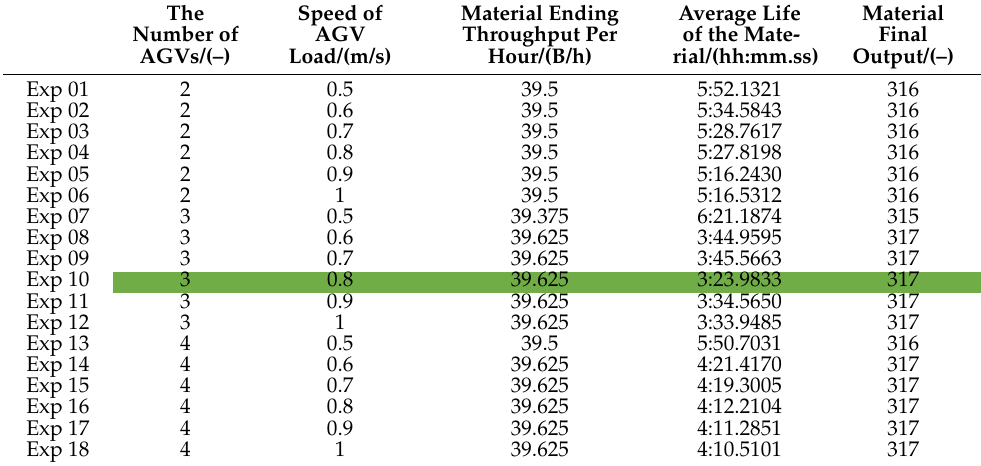
Table 10. Multi-level experiments for AGV number and load speed.